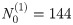
Biofilm growth simulation for bi-bacterial biofilm with toxic substance.Mean of 100 simulations in blue line with green star for the hours of experimental measurements, dotted lines for curves of minimum and maximum values, red diamonds for experimental data. (a) Initial proportion corresponding to the initialization of the mono-bacterial biofilms (36% for P. gingivalis: N0(1)=144, N0(2)=261) give a final proportion of 14% for P. gingivalis and 86% for S. gordonii, (b) Initial proportion of 2% for P. gingivalis (N0(1)=7, N0(2)=315) give a final proportion of 0.6% for P. gingivalis and 99.44% for S. gordonii.